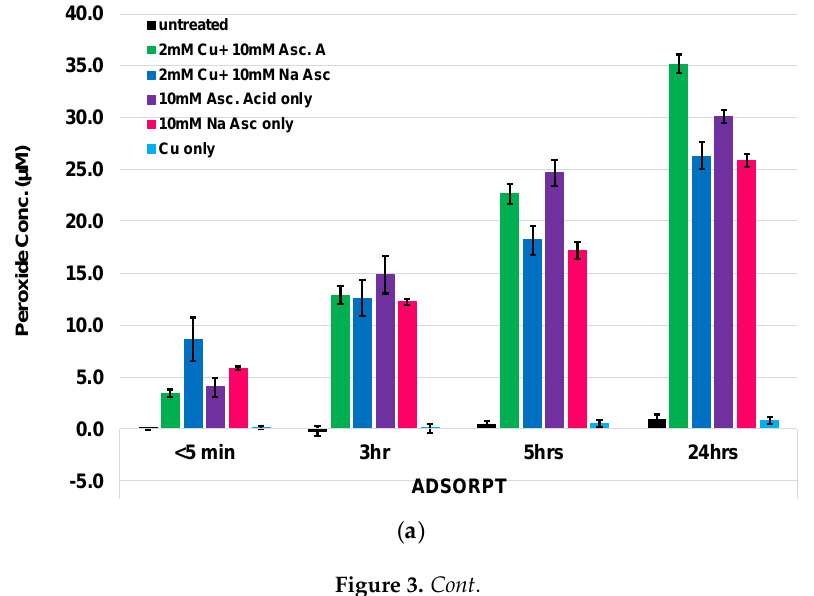
Table 2. Peroxide Production of copper (II) chloride in sodium ascorbate solution measured amplex red assay a .